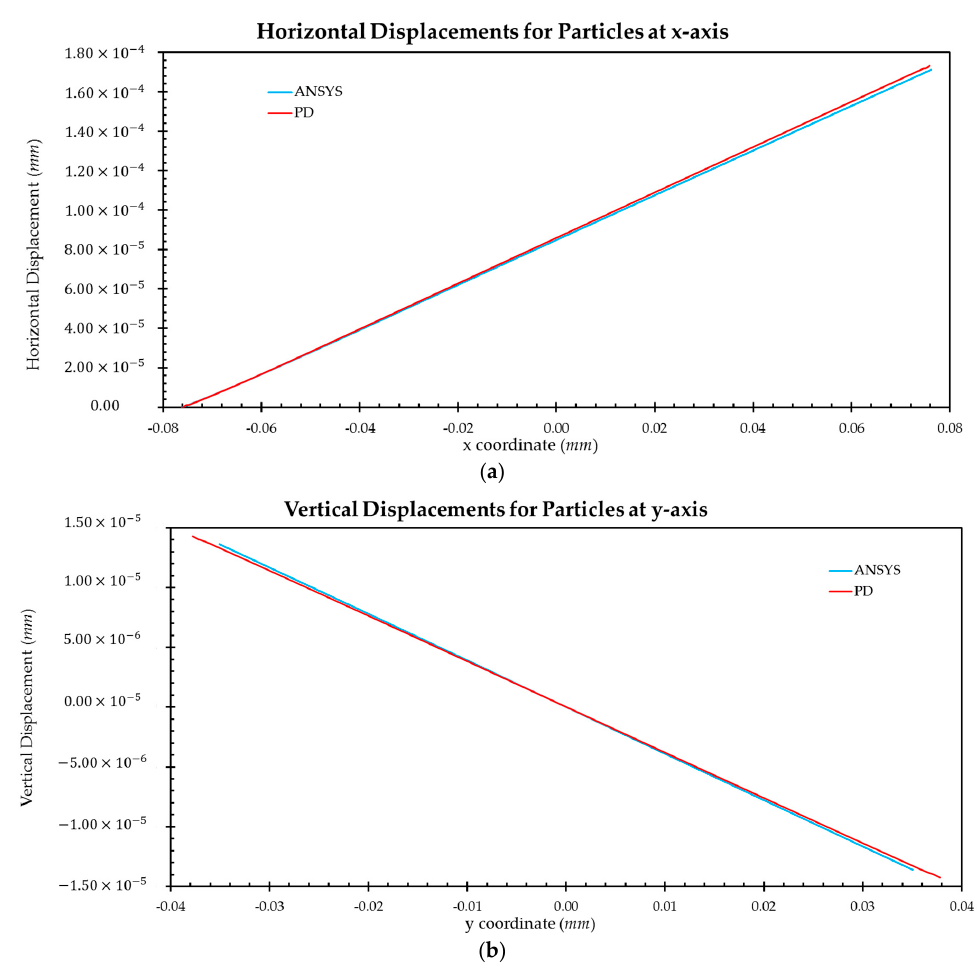
Figure 7. Comparison of displacements between FEM and PD analyses for Nb crystal for 0° orientation: ( a ) horizontal displacements for particles along the central x-axis; ( b ) vertical displacements for particles along the central y-axis.